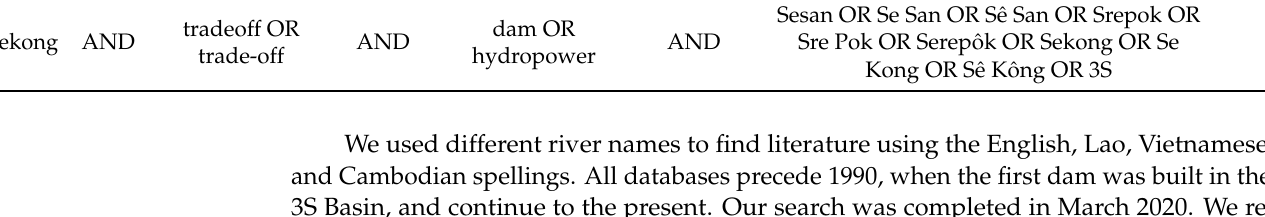
Table 1. Literature search teams and